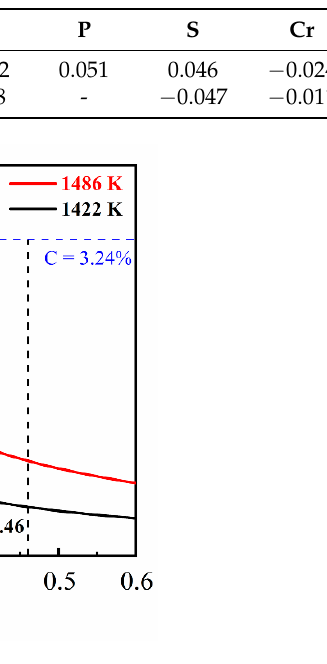
Figure 1. The solubility product curves of NbC in liquidus (1486 K) and solidus (1422 K). Figure 1 shows the solubility limits for dissolved niobium and carbon at the liquidus (1486 K) and solidus (1422 K) temperature of the grey cast iron. From Figure 1 it can be seen that, for a carbon content of 3.24%, the NbC will be precipitated in the liquid while Nb content has exceeded 0.14%. It can be found that NbC can be precipitated in the liquid while the niobium content is 0.27% and 0.46%. On the contrary, while the niobium content is 0.098% NbC will be precipitated at temperatures between the solidus and liquidus. When the temperature continues to drop towards the solidification process, the value of K NbC is decided by the solidification front temperature T s–l , which is expressed by Equa- tion (3) [16]: